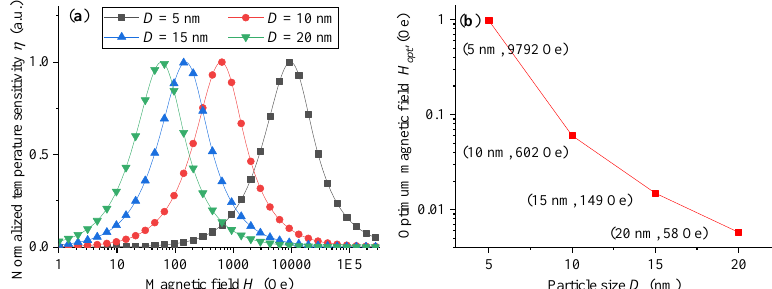
Figure 2. ( a ) The relationship between the temperature sensitivity ( η ) and static magnetic field (H) for different MNP size ( D ). ( b ) Influence of particle size ( D ) of MNPs on their optimal static magnetic field (H opt ).